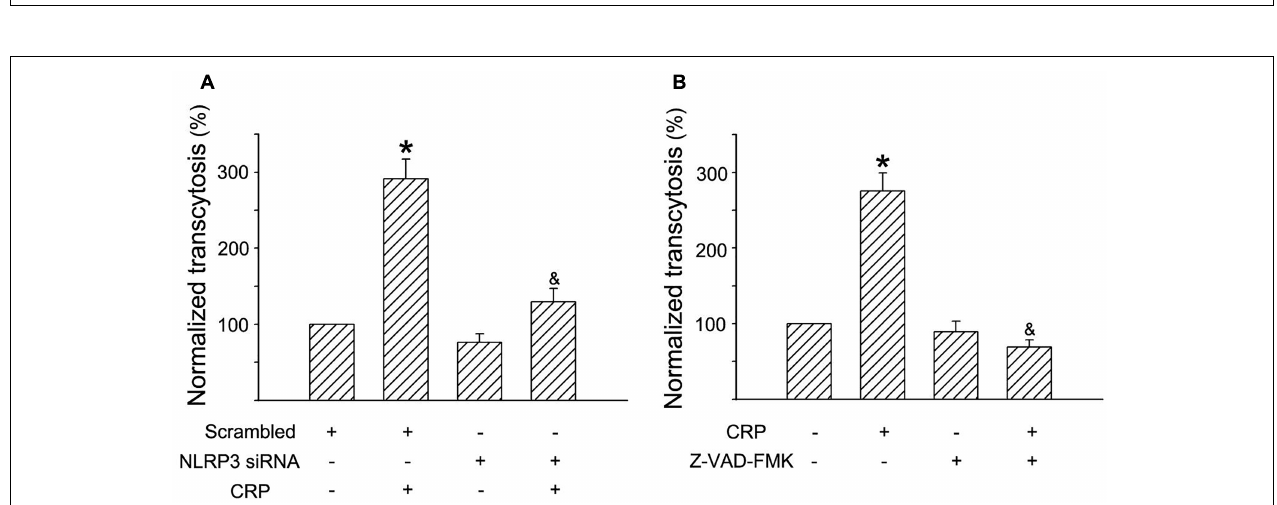
FIGURE 6 | Effects of NLRP3 inflammasome on CRP-mediated LDL transcytosis in HUVECs. HUVECs were transfected with 20 µ mol/L NLRP3 siRNA, 20 µ mol/L Scrambled siRNA for 24 h or incubated with 20 µ mol/L Z-VAD-FMK for 1 h, and then were treated in the absence or presence of 20 µ g/mL CRP for 24 h. (A) Effects of NLRP3 siRNA on CRP-induced LDL transcytosis in HUVECs. ∗ P < 0.05 vs. Scrambled siRNA; & P < 0.05 vs. CRP; n = 4. (B) Effects of Z-VAD-FMK on CRP-induced LDL transcytosis in HUVECs. ∗ P < 0.05 vs. Ctr; & P < 0.05 vs. CRP; n = 4.